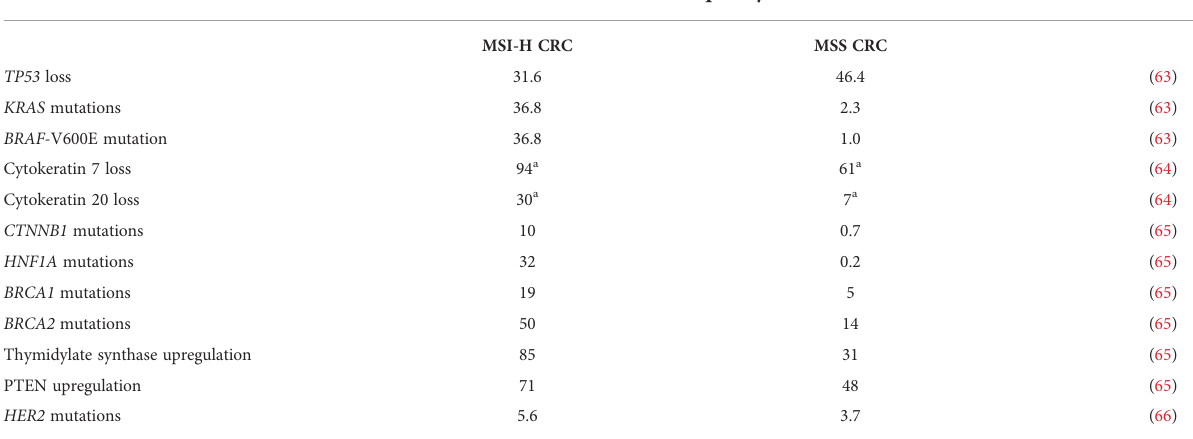
TABLE 2 Frequency of common mutations in MSI-H and MSS